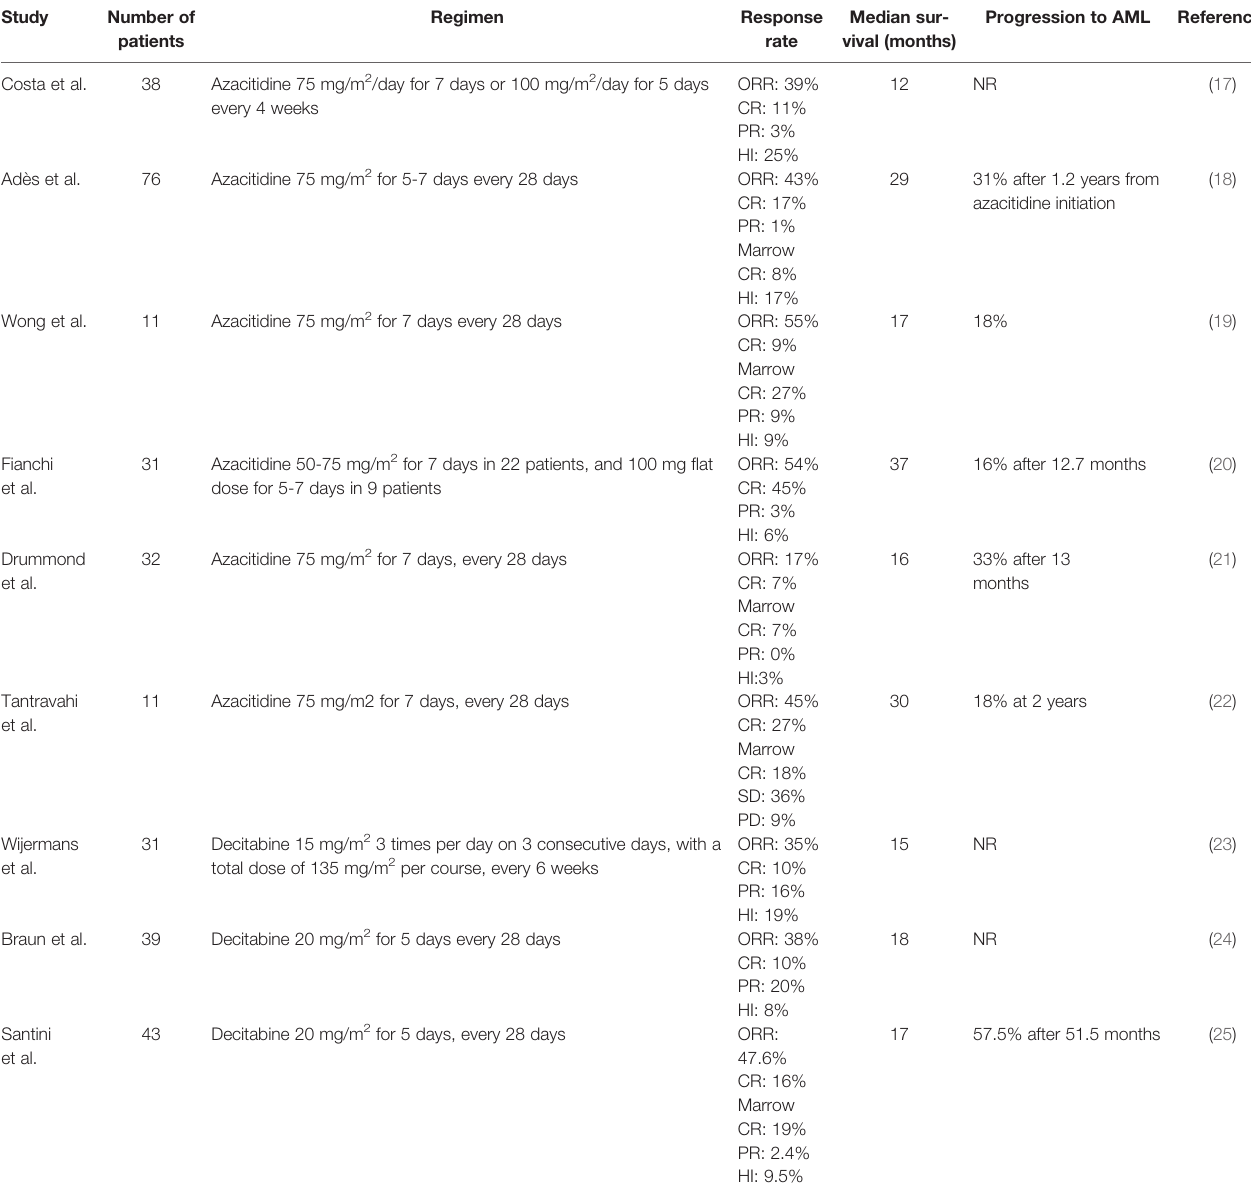
TABLE 1 | Phase II studies of hypomethylating agents in chronic myelomonocytic